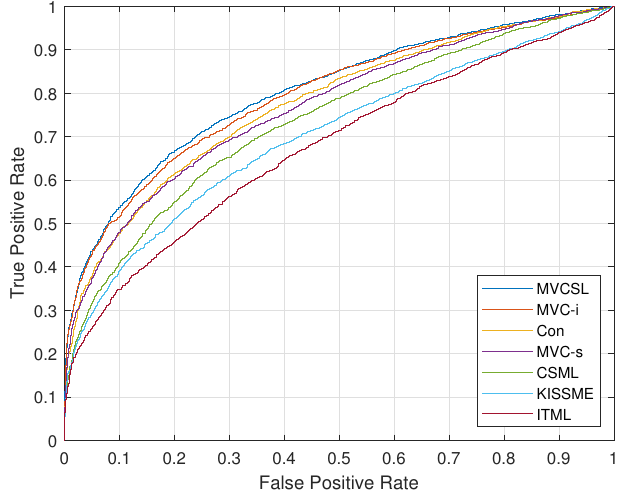
Figure 4. ROC curves of various approaches on the FGLFW